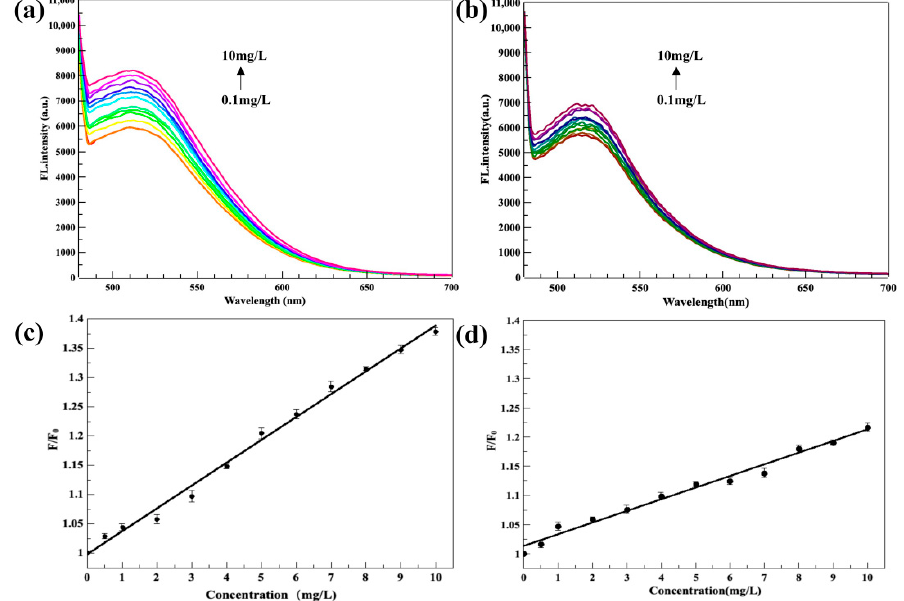
Figure 4. Fluorescence emission spectra of N, S-GQDs@ZIF-8@MIP ( a ) and N, S-GQDs@ZIF-8@NIP ( b ) under the different OA concentrations, the linear section of N, S-GQDs@ZIF-8@MIP ( c ) and N, S-GQDs@ZIF-8@NIP ( d